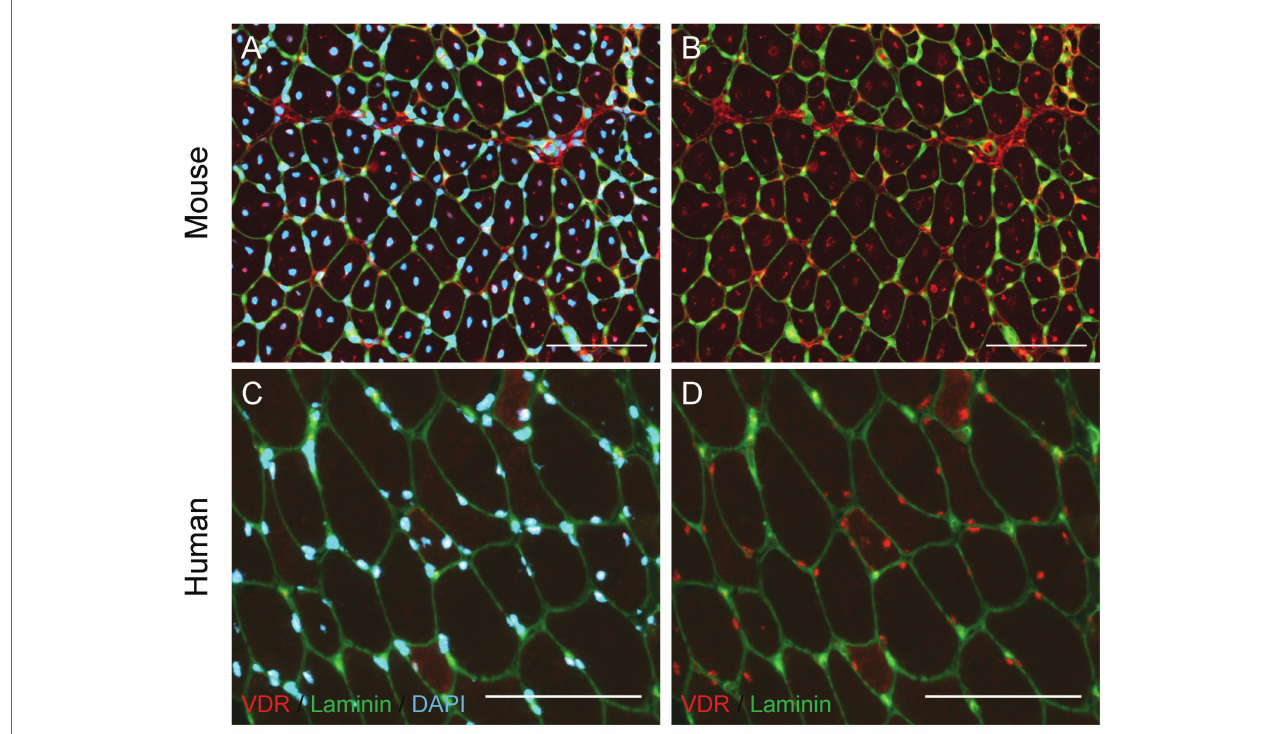
FIGURE 2 | Localization of Vitamin D Receptor (VDR) in regenerating mouse and human skeletal muscle. (A,B) Muscle regeneration was induced in the mouse tibialis anterior muscle by injecting BaCl 2 (1.2%), and the tibialis anterior muscle was harvested 7 days following injury. Immunohistochemical analysis revealed regenerating fibers with centrally-located myonuclei ( A , DAPI) show strong positive VDR expression ( B , red puncta) in myonuclei. (C,D) A vastus lateralis biopsy was obtained from a human research participant 7 days after severe thermal injury, which we have shown to induce significant skeletal muscle regeneration (Fry et al. 2016). Myonuclear localization of VDR ( D , red puncta) is observed, with the strongest VDR intensity present within myonuclei ( C , DAPI) of small, regenerating fibers. In all images, laminin (green) denotes the fiber border. In images A and C , DAPI (blue) denotes nuclei. In images B and D , DAPI is omitted to allow visualization of VDR staining within nuclei. Scale bar = 100 μ